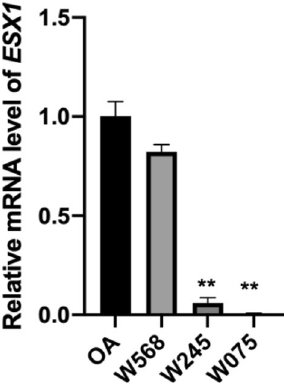
Figure 5. ESX1 mRNA levels in NOA patients harboring ESX1 mutations. RNA was extracted from FFPE testicular samples and then reverse-transcribed into cDNA. Compared with patient with OA, ESX1 mRNA level was substantially decreased in patients harboring the p.R281H (W245) or p.[P365R; L366V] (W075) mutation. ** P < 0.01.